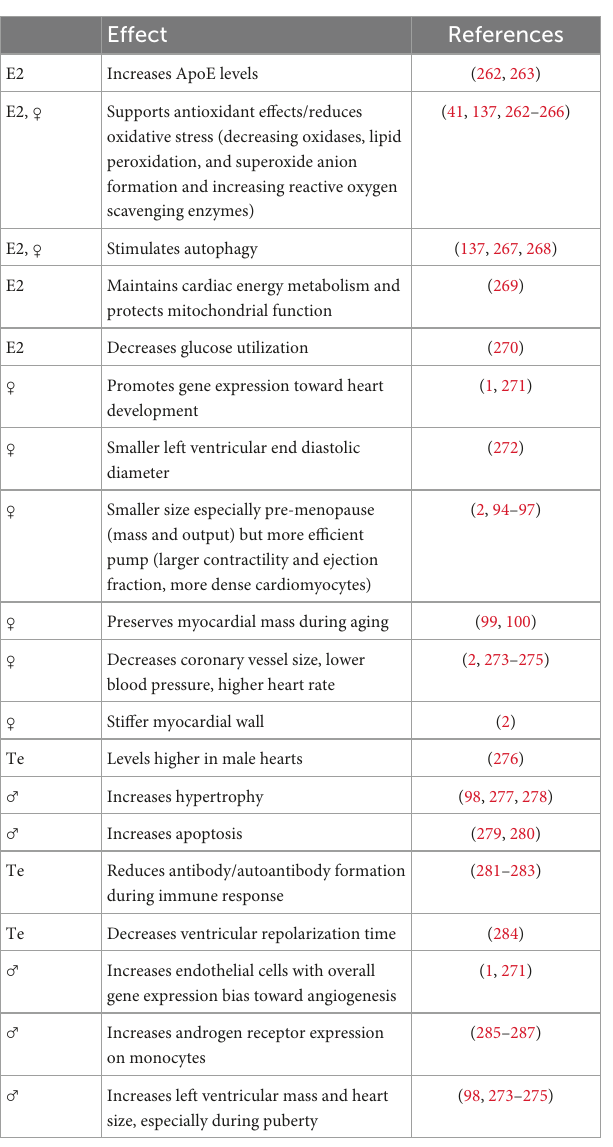
TABLE 4 Effects of sex hormones and/or sex differences in the basic physiology of the